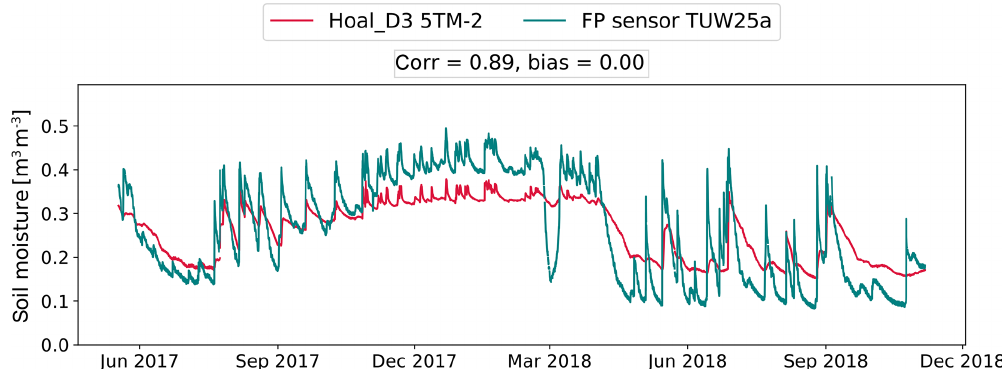
Figure A5. Soil moisture time series of FP sensor TUW25a and professional probe Hoal_D3 at a depth of 0.05m, installed next to each other.